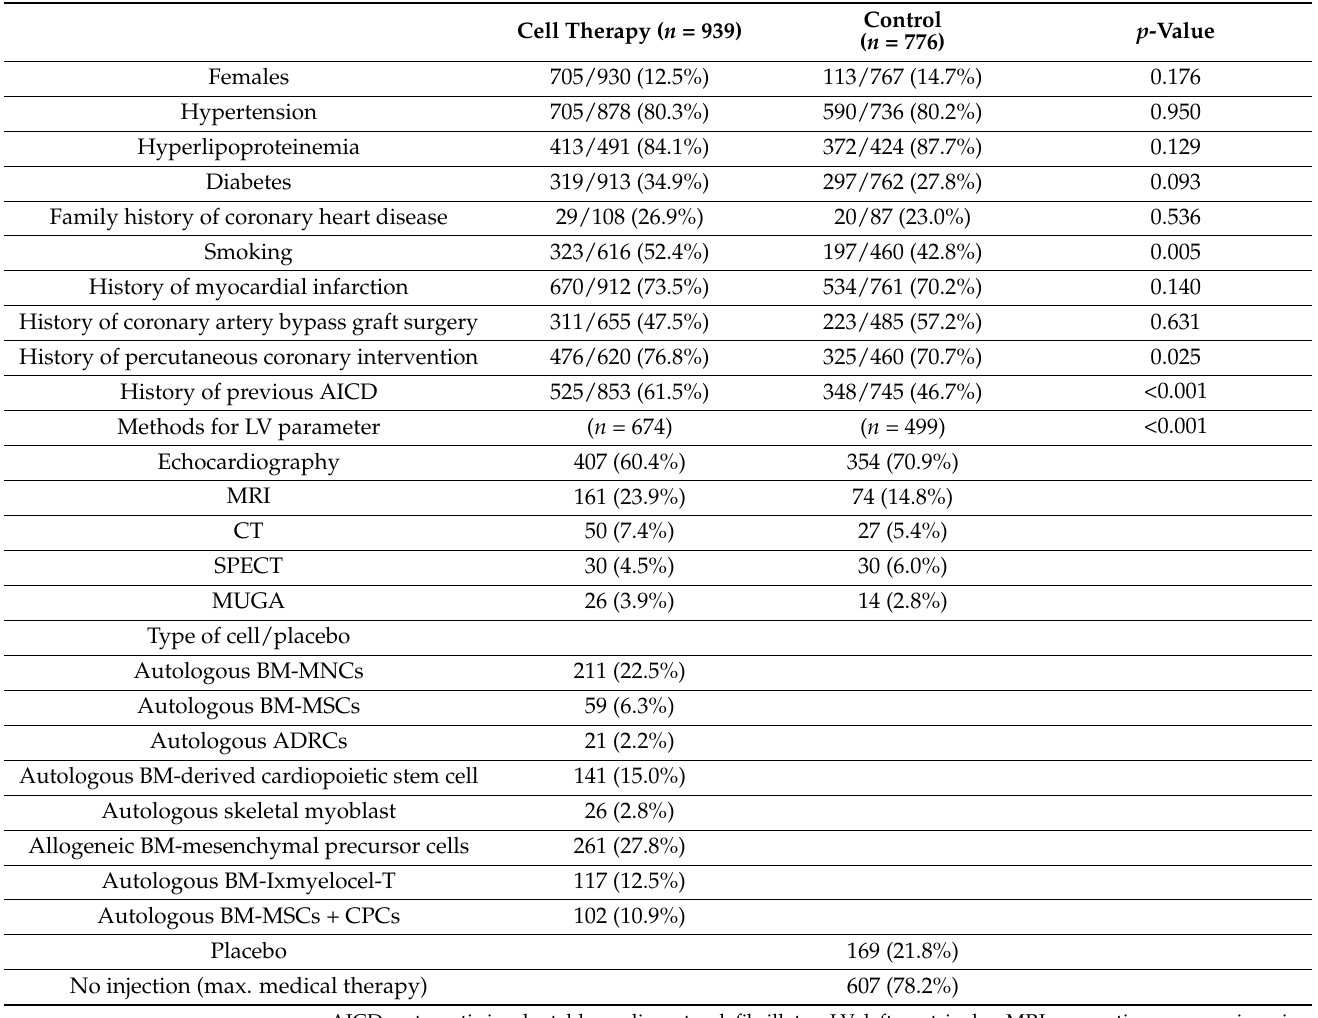
Table 2. Patient characteristics at